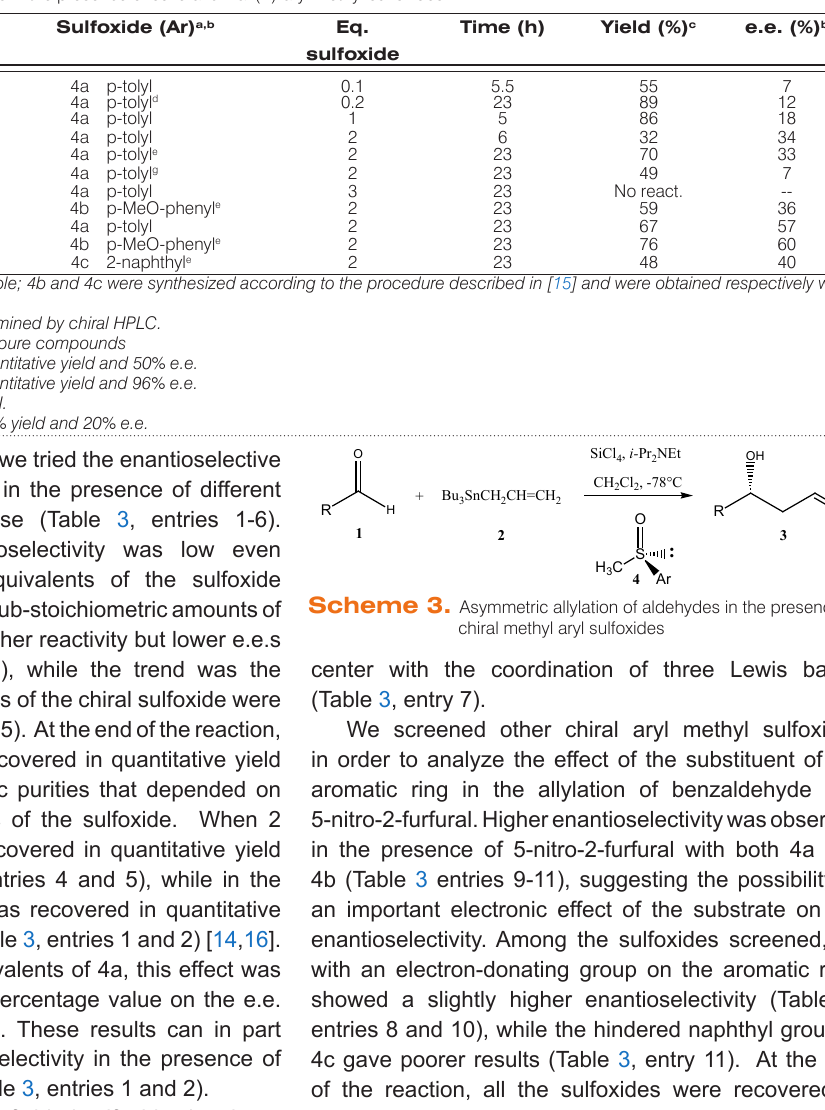
Table 3. Allylation of aldehydes in the presence of several chiral (R)-aryl methyl